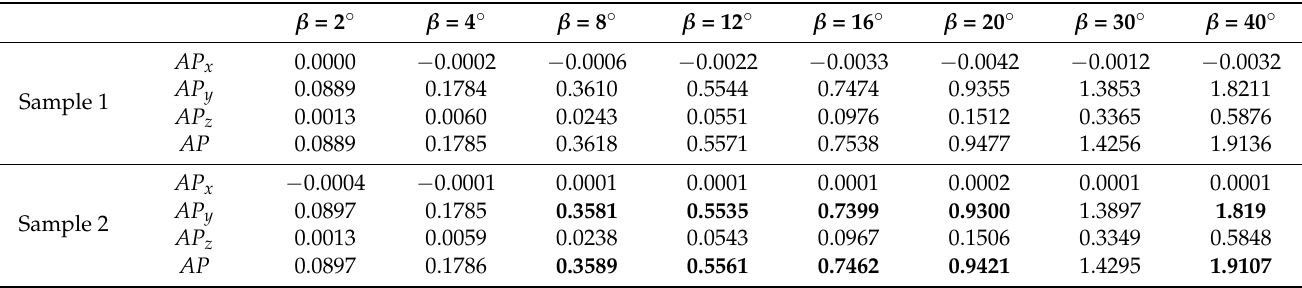
Table 5. Positioning accuracy AP [mm] components for Probe 2 ( ∅ 5 mm).